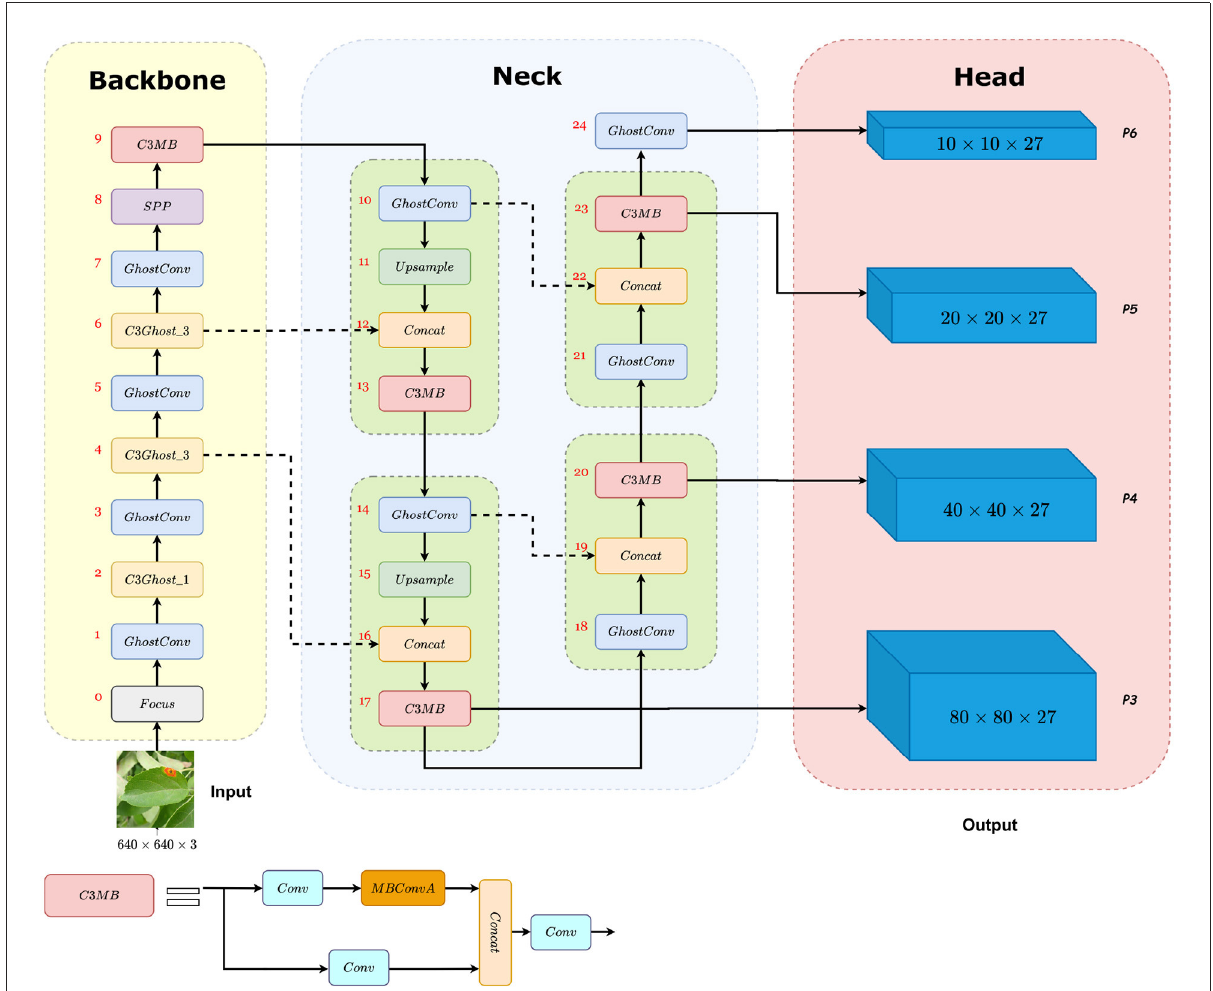
FIGURE6 The architecture of the MGA-YOLO network. Backbone : CSPDarknet with Focus, GhostConv (the Ghost module), C3Ghost_X, and SPP. Neck : PANet with C3MB. Head : four prediction heads P3, P4, P5, P6 detect small, medium, large, and extra large objects, respectively. Firstly, 640 RGB images are given as the input, then the image features are extracted and fused through Backbone and Neck. Finally, four prediction heads with four different sizes and 27 channels are the output. Each prediction head corresponds to three anchor boxes and each anchor box predicts the probability of four categories, four attributes of the predicted bounding box ( x , y , w , h ) and the confidence of the predicted result. Therefore, the number of prediction head channels is 3 (4 4 1) × + + =